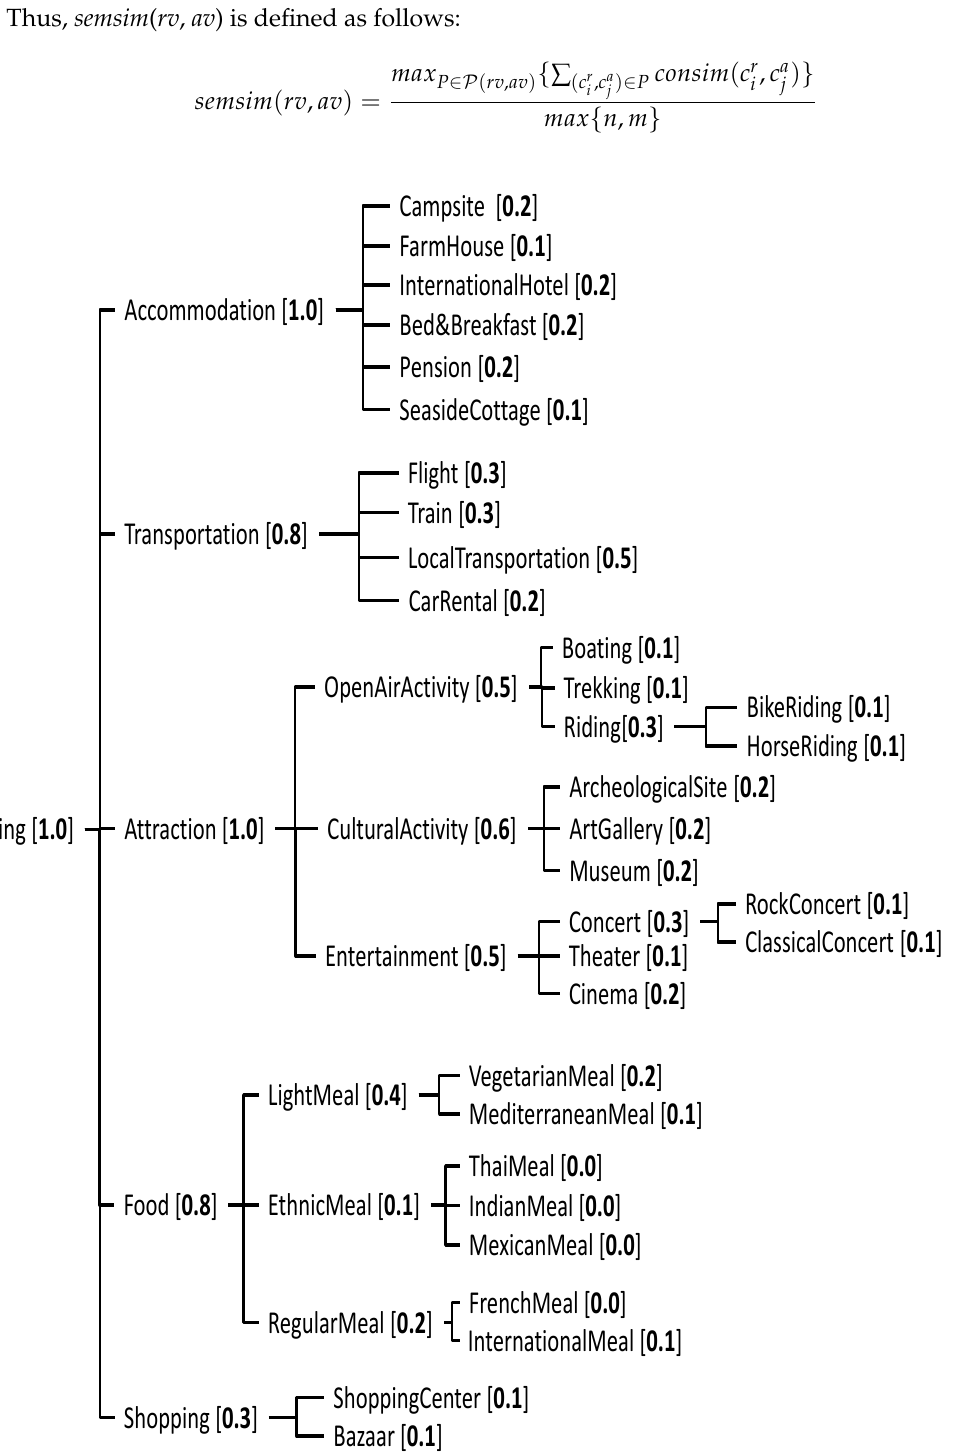
Figure 1. A Weighted Reference Ontology ( WRO ) in the tourism